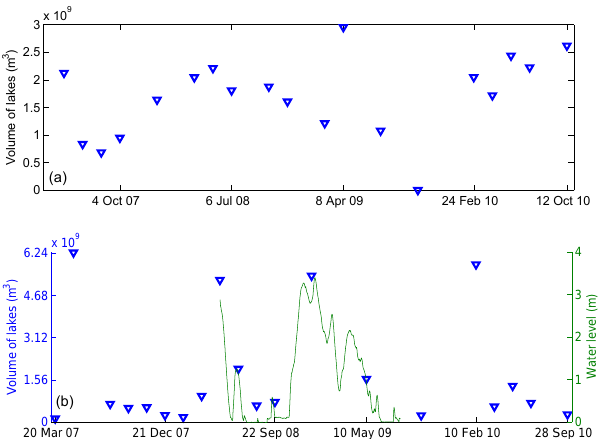
Figure 12. Estimates of total volume of lakes in the Kapuas (a) and the Mahakam (b) lowlands derived from flooded pixel areas in PAL- SAR images. Note that stream network was not removed during the flood count assessment, which renders the area of inundation some- what overestimated.